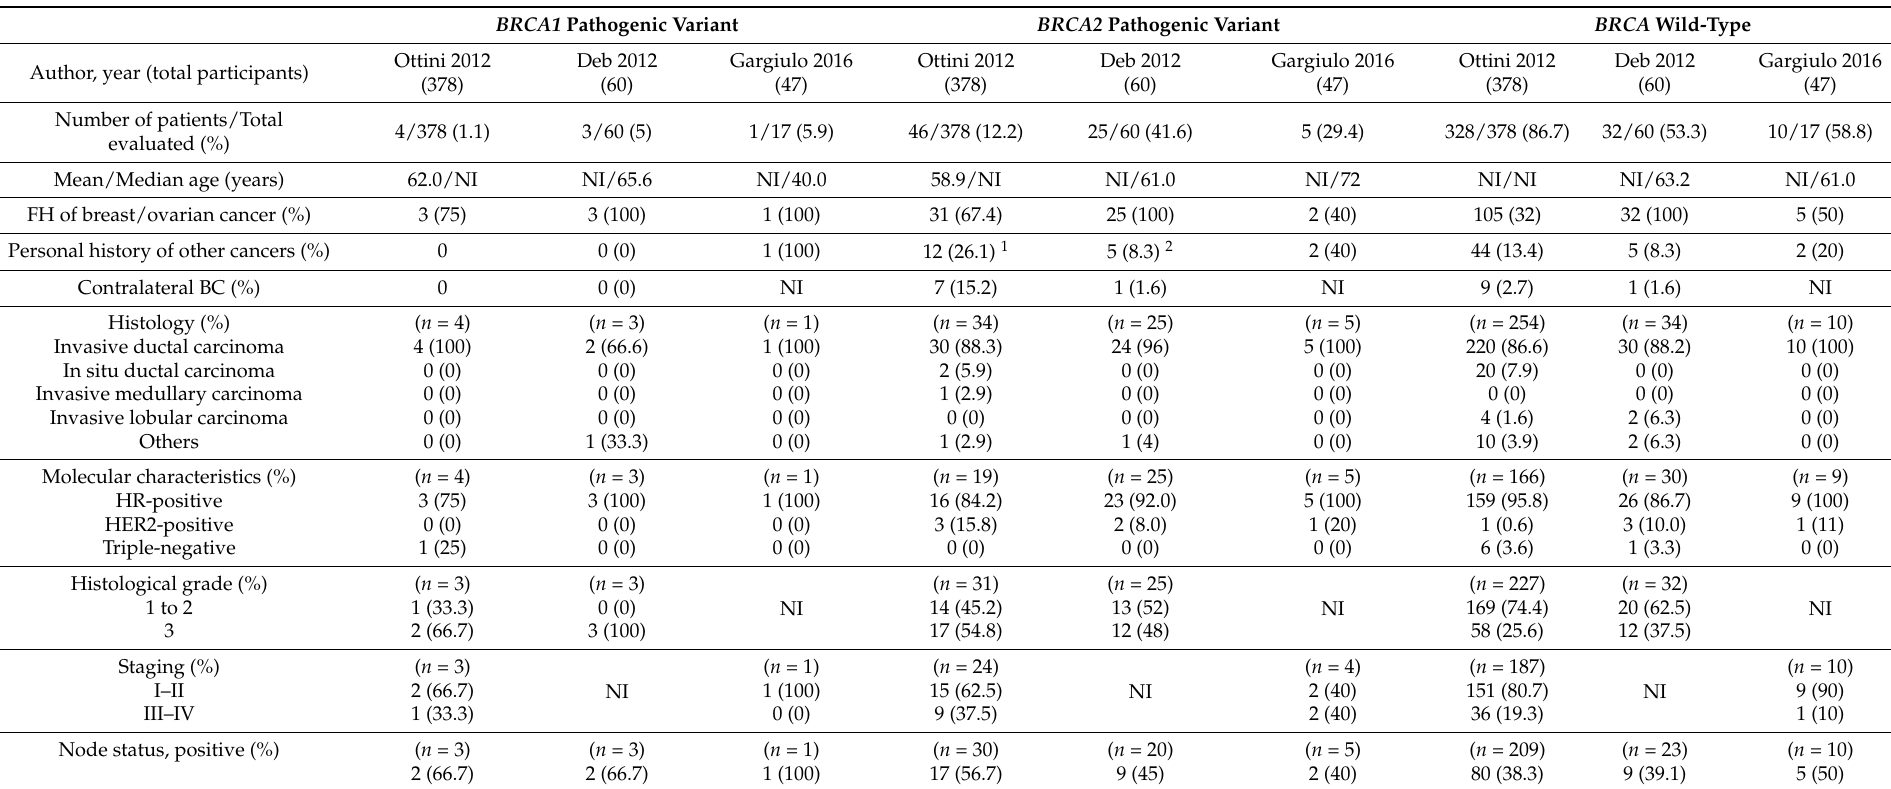
Table 1. Selected studies evaluating the association between clinic–pathological characteristics and the BRCA1/2 status in MBC. BRCA1 Pathogenic